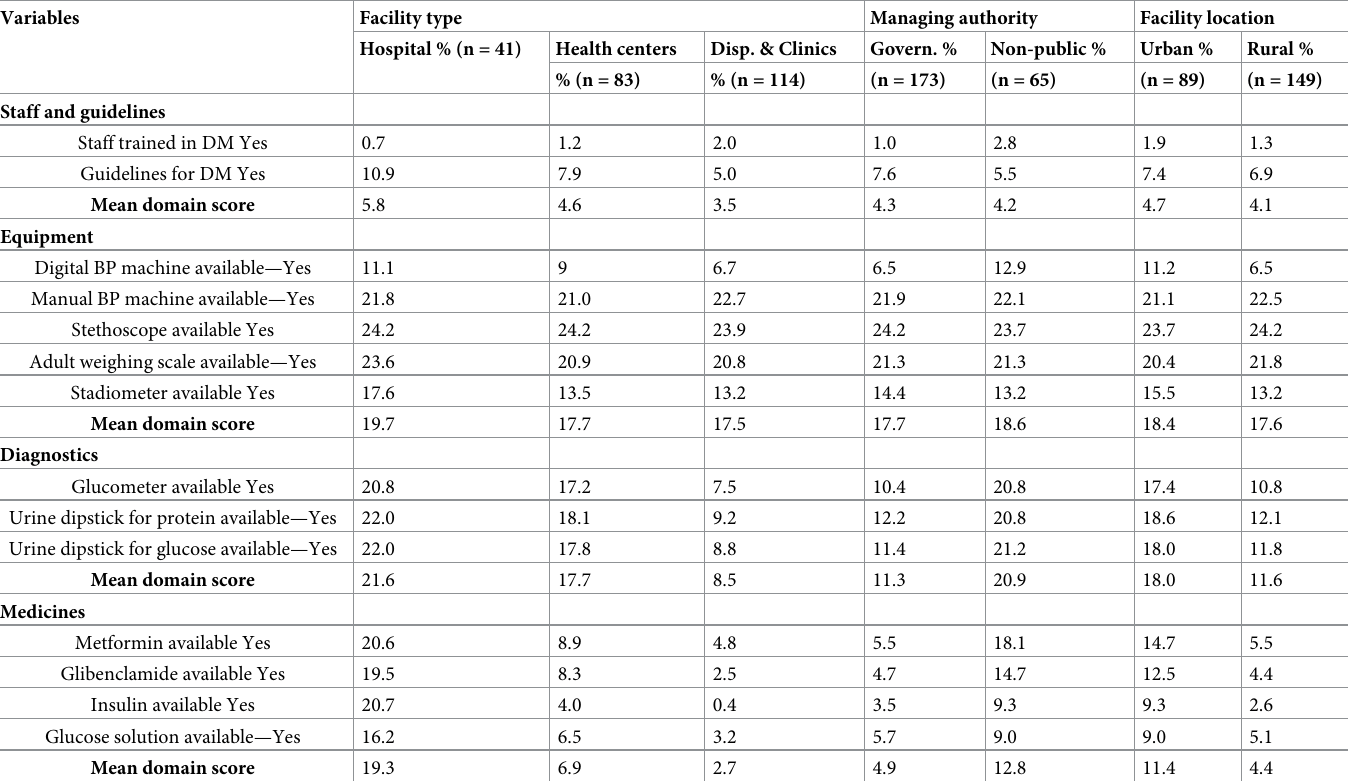
Table 2. Domain-specific readiness for DM management by facility characteristics (N =